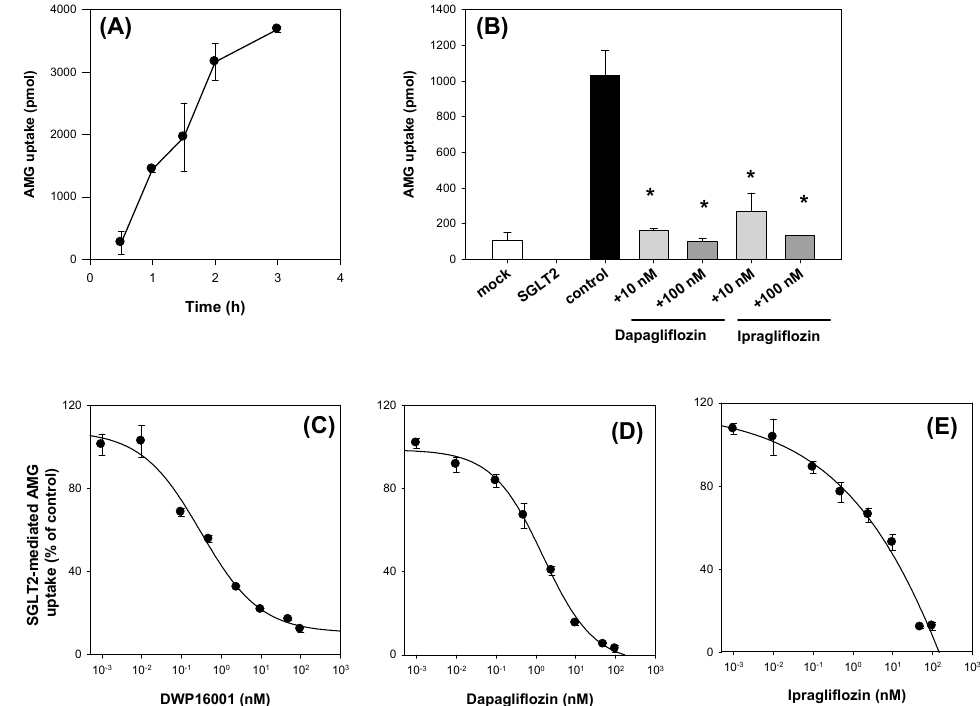
Figure 8. ( A ) The uptake of 10 µM [ 14 C]methyl-a-D-glucopyranoside (AMG) was measured in CHO-SGLT2 cells with a various incubation time (0.5, 1, 1.5, 2, 3 h). ( B ) Inhibitory effect of dapagliflozin and ipragliflozin (10, 100 nM) on the uptake of 10 µ M [ 14 C]AMG in CHO-mock and –SGLT2 cells was measured for 2 h. RepresentativeconcentrationdependentinhibitionofDWP16001( C ),dapagliflozin( D ),andipragliflozin ( E ) on the SGLT2-mediated uptake of [ 14 C]AMG. SGLT2-mediated uptake of [ 14 C]AMG was